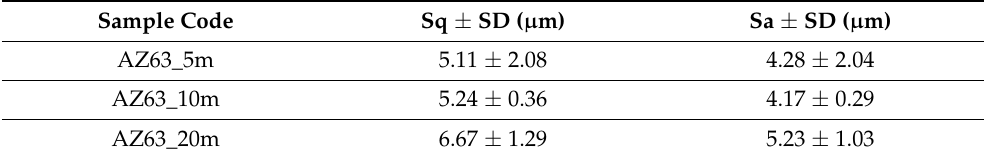
Figure 4. Example of a 3D SEM-BSE topographical analysis performed on sample AZ63_10m: the four BSE images acquired on the same surface by the four channels of the BSE detector ( a ); generated 2D surface height map ( b ); 3D surface rendering ( c ); topographic cross-section profile ( d ). Table 2. Surface roughness